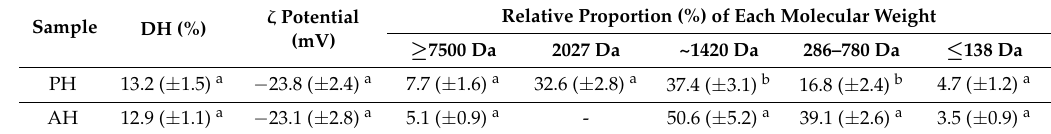
Table 2. Characterization of PH and